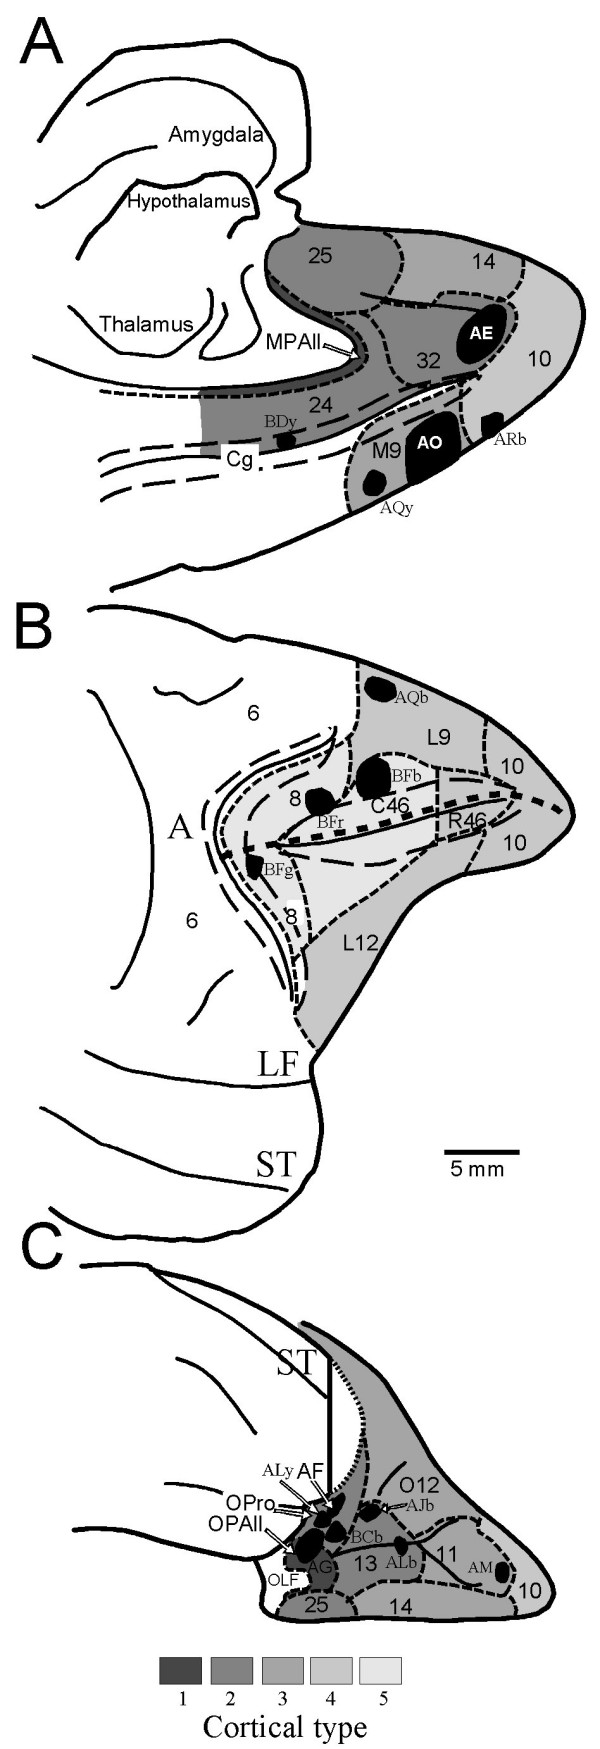
Composite of injection sites shown on the medial (A), lateral (B) and orbital (C) surfaces of the right cerebral hemisphere. The injection sites are superimposed on an architectonic map of the prefrontal cortex [38]. Different cortical types are depicted in shades of grey as follows: 1 (darkest grey) agranular areas with three distinguishable layers; 2, dysgranular areas with four distinguishable layers, including a poorly developed layer IV; 3–5, eulaminate areas with increasing cellular density and thickness of layer IV from levels 3 to 5. In A-C, small dashed lines demarcate architectonic areas indicated by numbers; large dashed lines depict the cortex buried in sulci. MPAll, OPAll, OPro, OLF indicate architectonic areas. Letters before architectonic areas designated by letters or numbers denote: C, caudal; L, lateral; M, medial; O, orbital; R, rostral. Other letter combinations refer to cases. Abbreviations: A, arcuate sulcus; Cg, cingulate sulcus; LF, lateral fissure; ST, superior temporal sulcus.